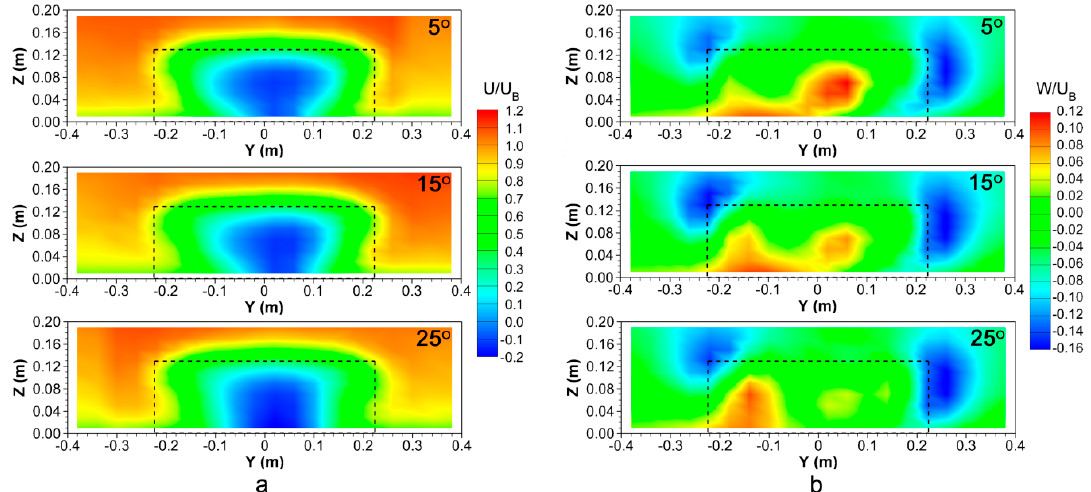
Figure 7. Spatial distributions of ( a ) streamwise ( U ) and ( b ) vertical ( W ) air velocities at Plane 1 for roof slopes of 5°, 15°, and 25°. U B is the streamwise air velocity at the building height. Black dash lines indicate the profile of the scaled model.